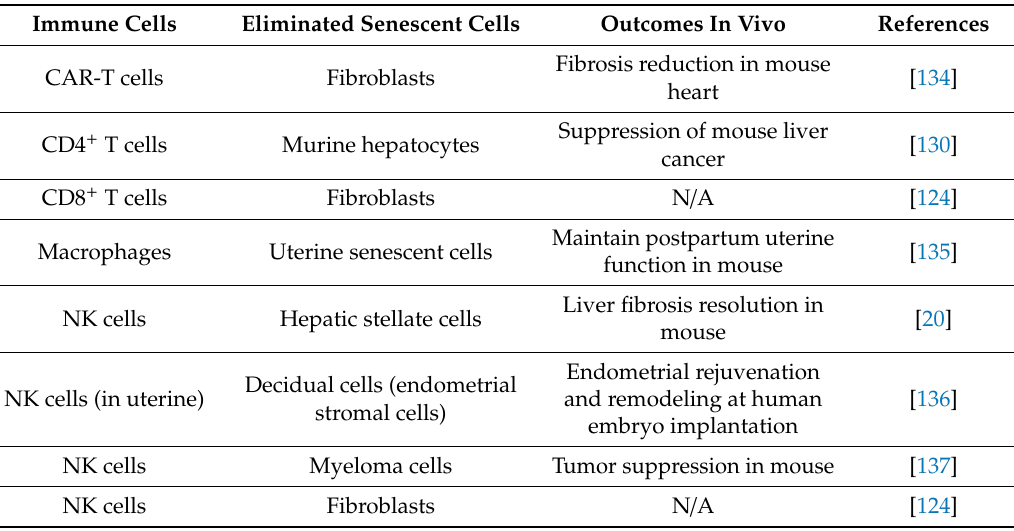
Table 2. Elimination of senescent cells by immune